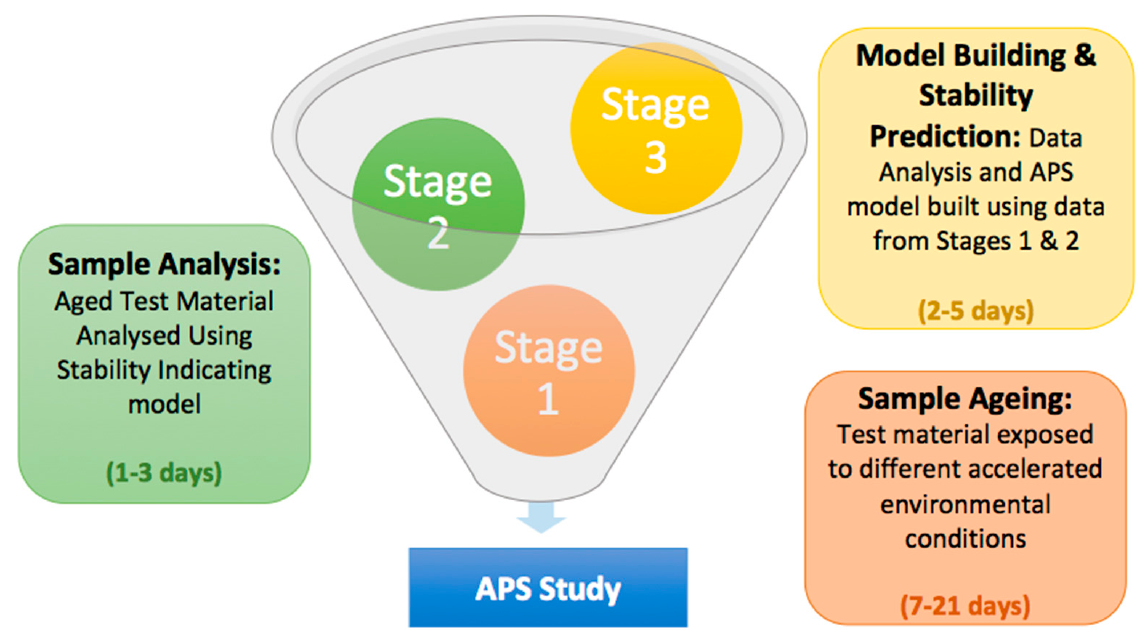
Figure 11. Schematic representation of the stages of an APS study.